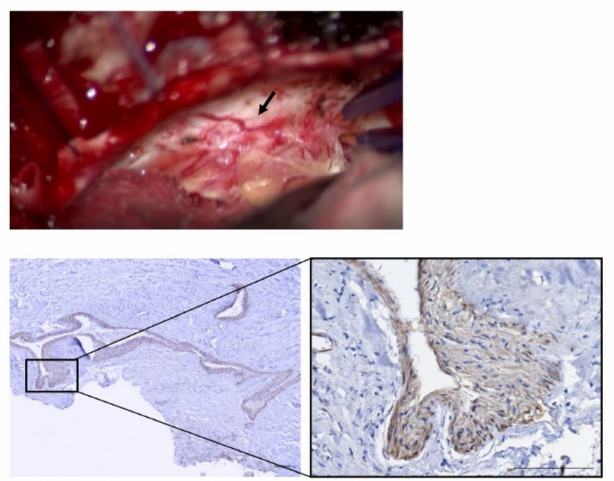
Figure 5. α SMA expression of the dura mater around internal auditory meatus (IAM) in Case 1. Intraoperative findings of the dura mater around IAM. The dilated vessels are shown on the dura mater (black arrow). Low- and high-magnification images are shown (scale bar = 100 µ m). Large multilayered vessel with α SMA(+) vascular smooth muscle cells are observed in the dura mater, which are similar to